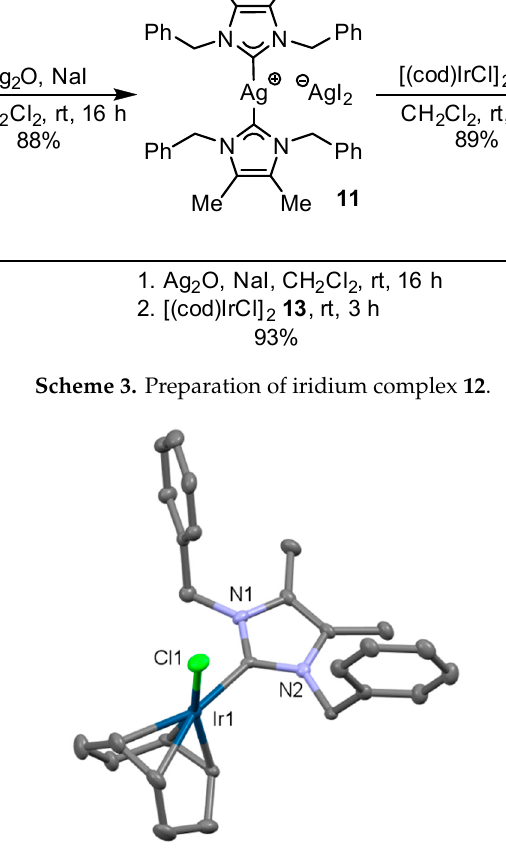
Figure 5. Molecular structure of 12 as determined by single crystal diffraction. Atoms are shown as 50% probability ellipsoids. H atoms and disorder in the orientation of one phenyl ring have been omitted for clarity.